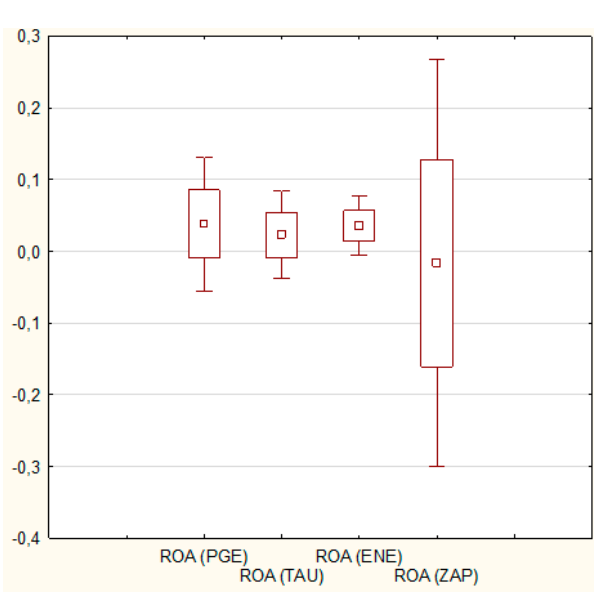
Figure 4. Box plot for ROA. Source: Own elaboration.